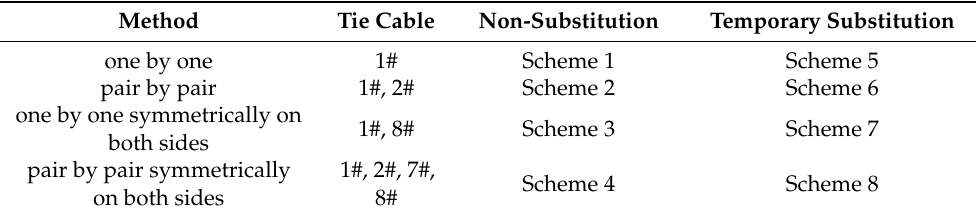
Table 1. Design of the cable replacement schemes.